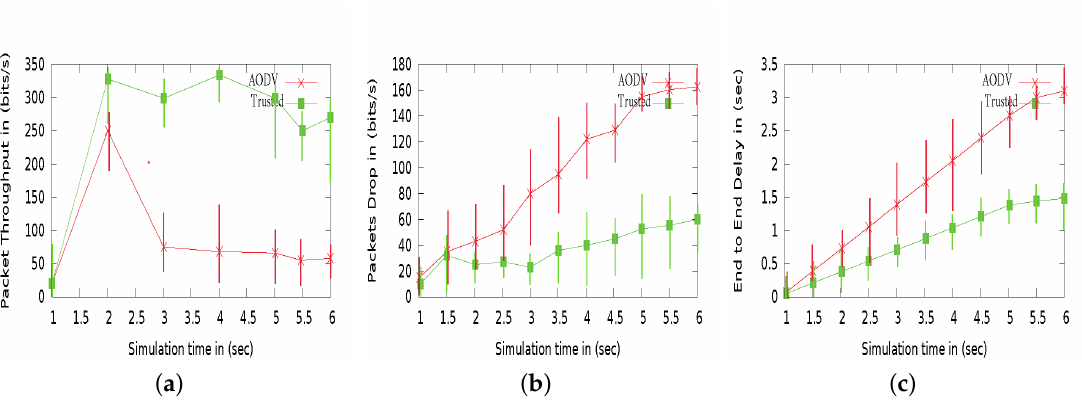
Figure 11. Comparison results between the original AODV and the trusted AODV under Black Hole attacks with parameters R = 250 m, V = 5 m/s, and N = 20: ( a ) packet Throughput. ( b ) Packet Drop in (%). ( c ) End-to-end